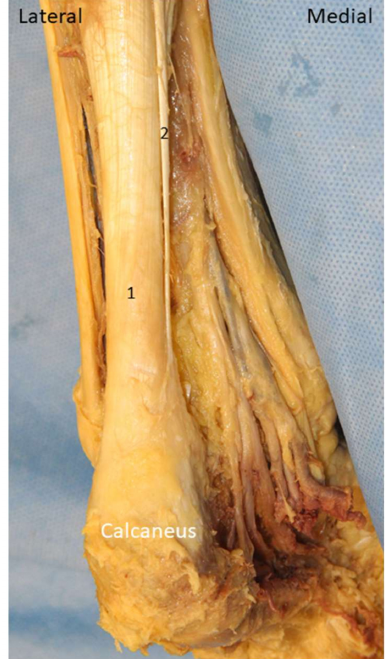
Figure 22. The plantaris tendon on the cadaveric model. 1: Achilles tendon; 2: plantaris tendon.